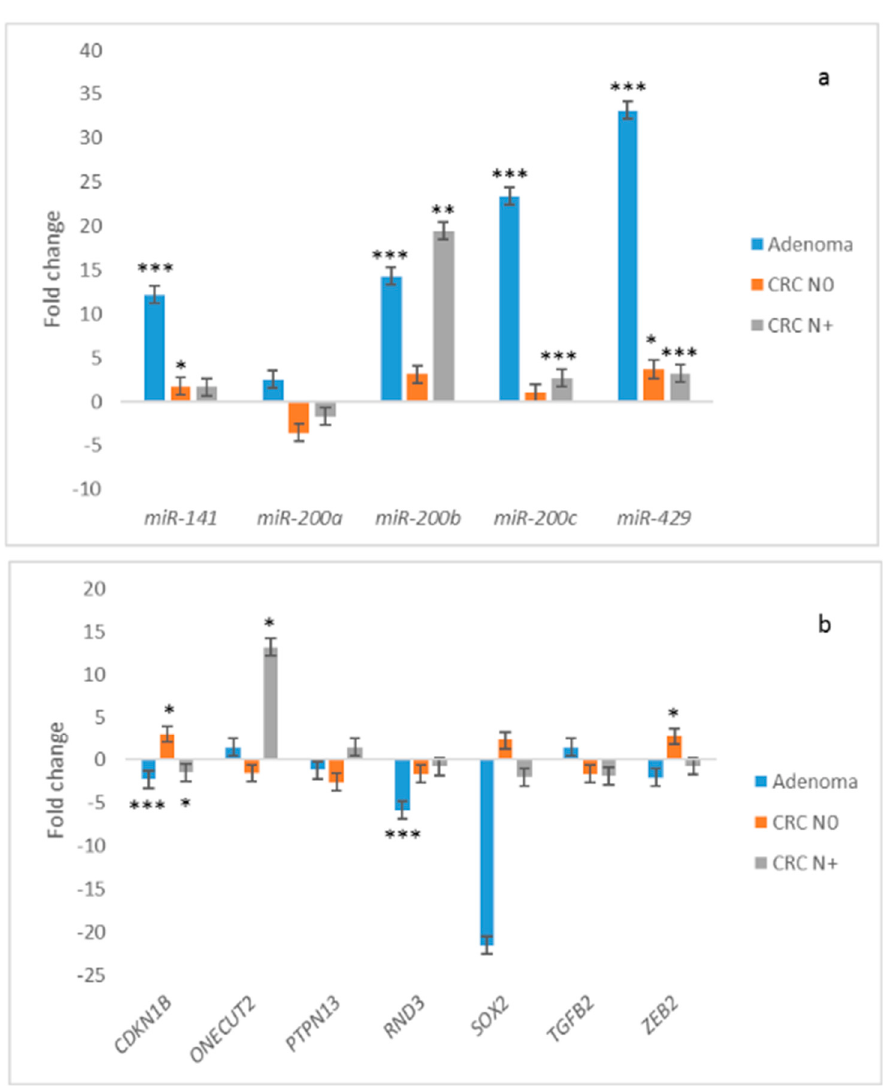
Figure 3. Expression of miR-200 family and their target genes in adenoma ( n = 10), CRC N0 ( n = 13) and CRC N + ( n = 17) in comparison with normal mucosa ( n = 13, n = 13 and n = 17, respectively): ( a ) Expression of miR-200 family; ( b ) expression of target genes of miR-200 family. Legend: CRC, colorectal carcinoma; N0, without nodal metastases; N + , with nodal metastases; * p ≤ 0.05; ** p ≤ 0.01; *** p ≤ 0.001.